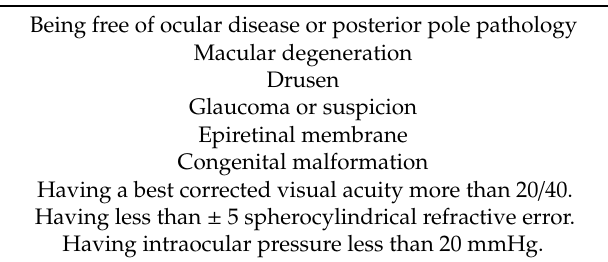
Table 2. Ophthalmological inclusion